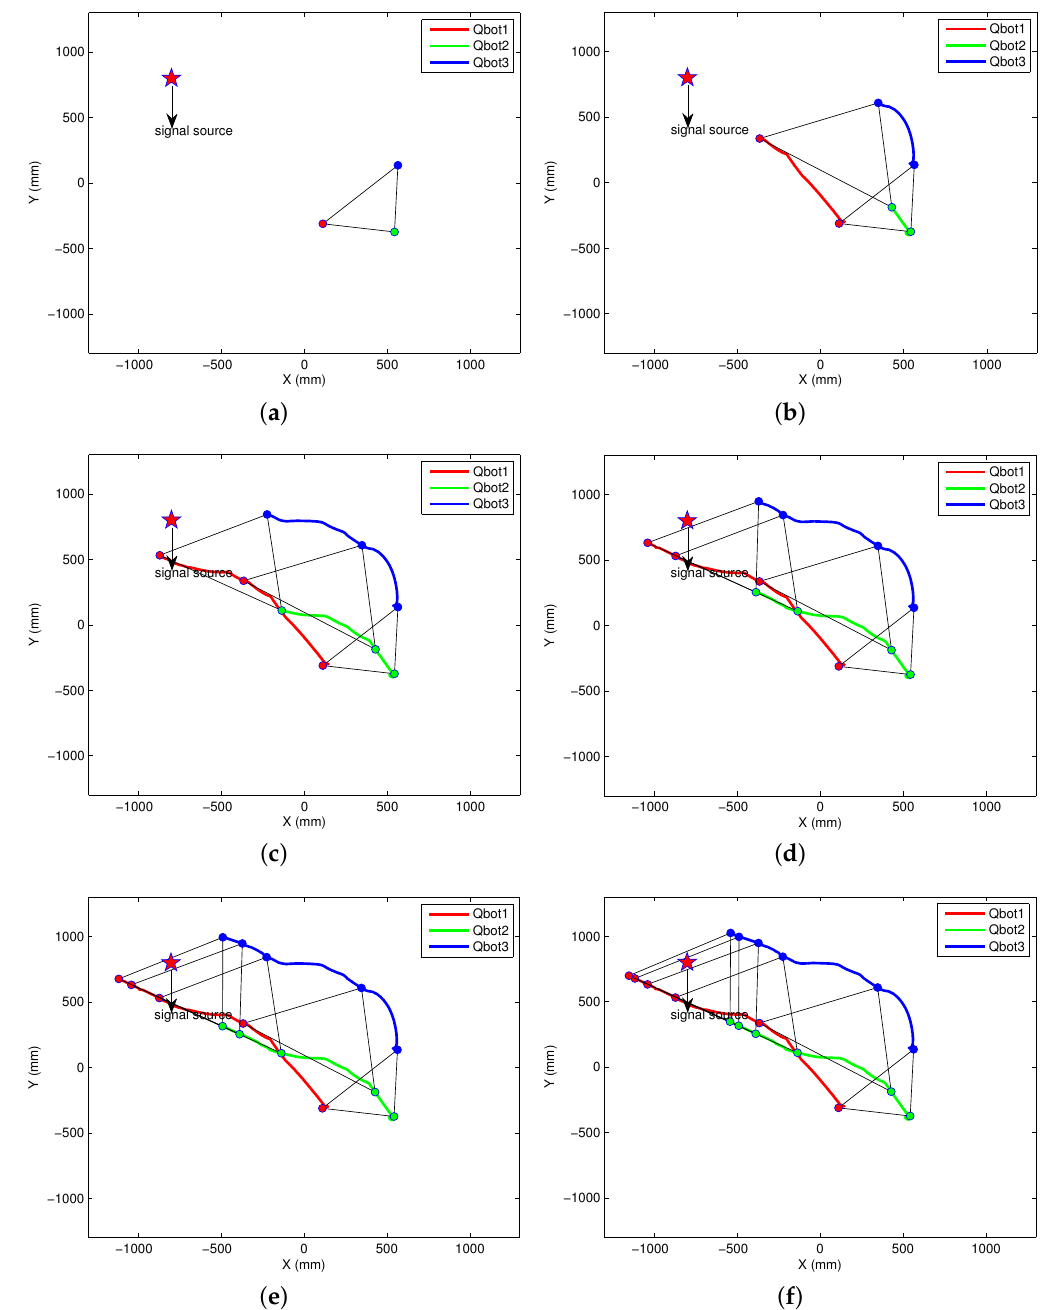
Figure 9. Movement trajectories of three robots where the red, blue and green lines denote the trajectories of three robots. ( a ) t = 0 s; ( b ) t = 4 s; ( c ) t = 8 s; ( d ) t = 12 s; ( e ) t = 16 s; ( f ) t = 20